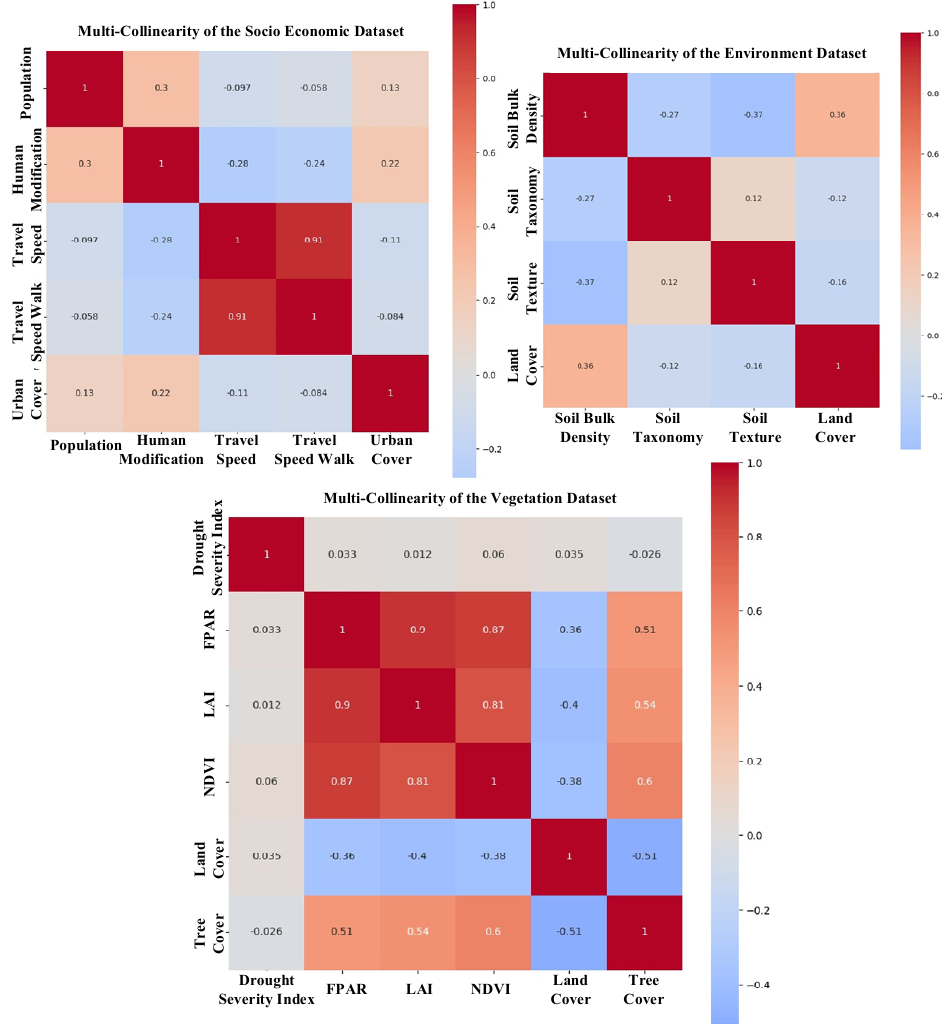
Figure 11. The correlation matrix of fuel factors as a heatmap.